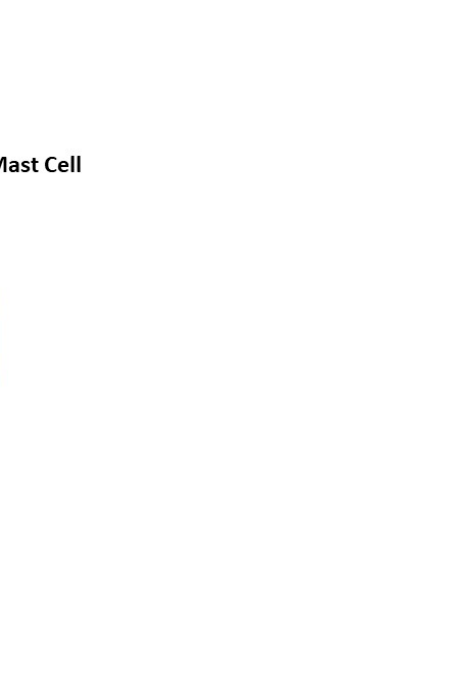
Figure 3. The mast cell (MC) can be activated by neurotensin (NT) through its receptor NTR1, leading to a biochemical cascade in the cytoplasm and nucleus that results in transcription proteins.